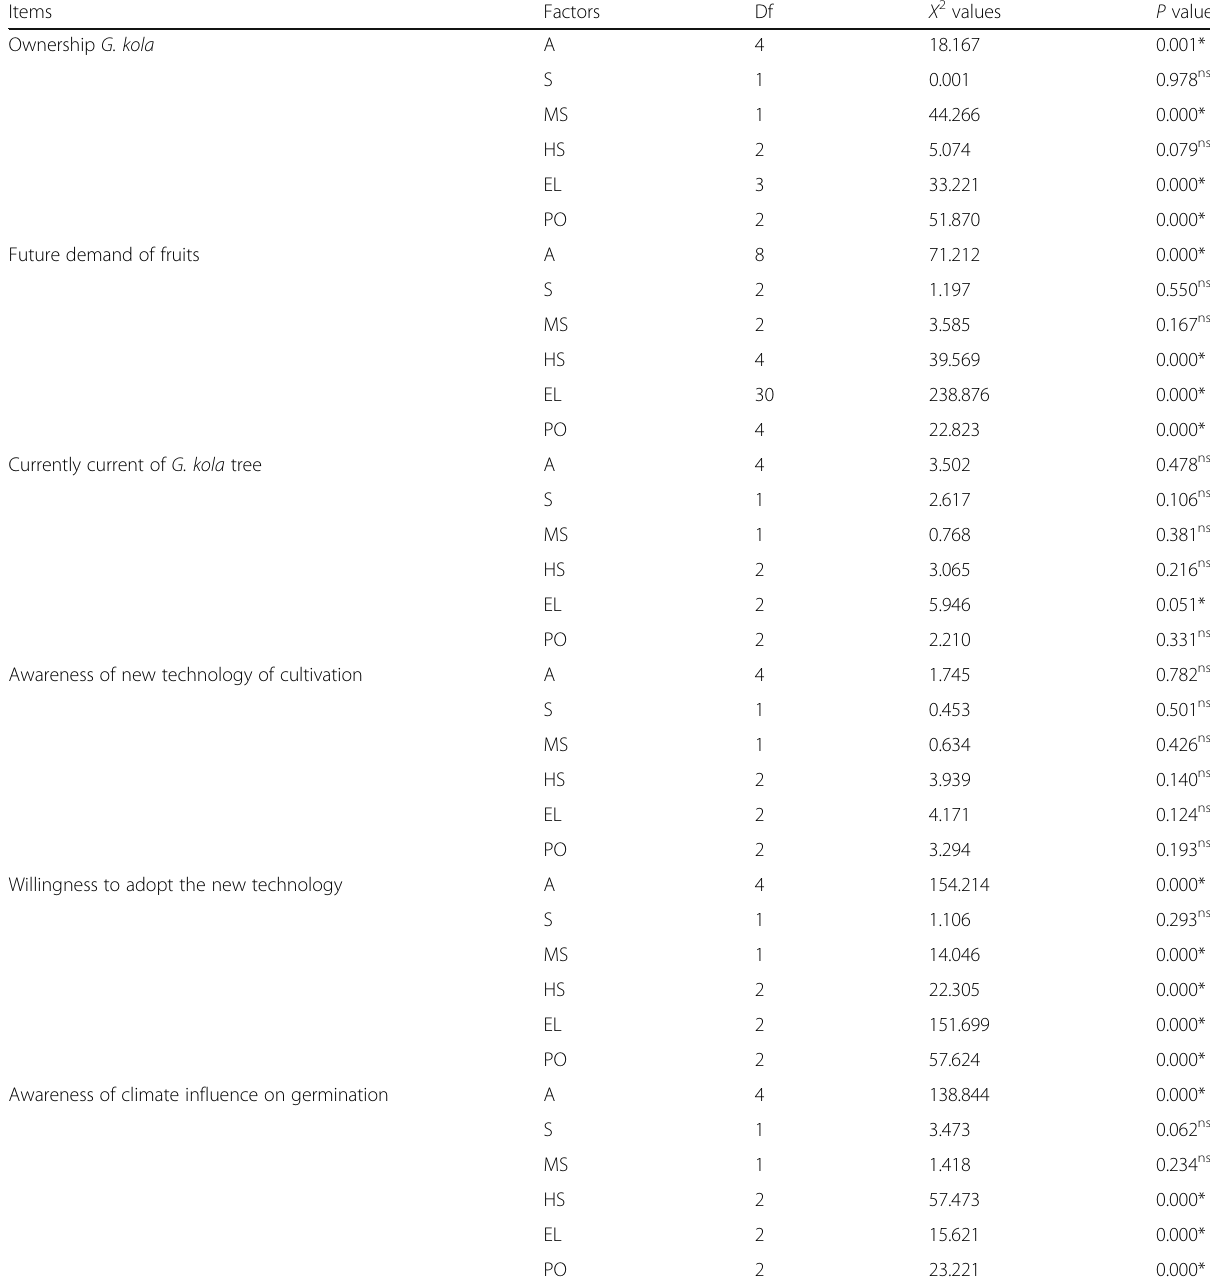
Table 2 Perception of respondent on propagation ability of G. kola